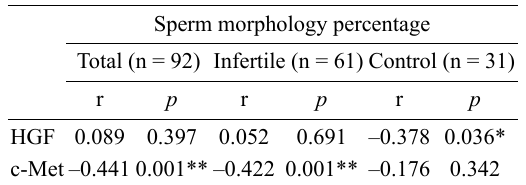
Table 6. Correlation between sperm morphology percentage and HGF and c-Met expression levels.